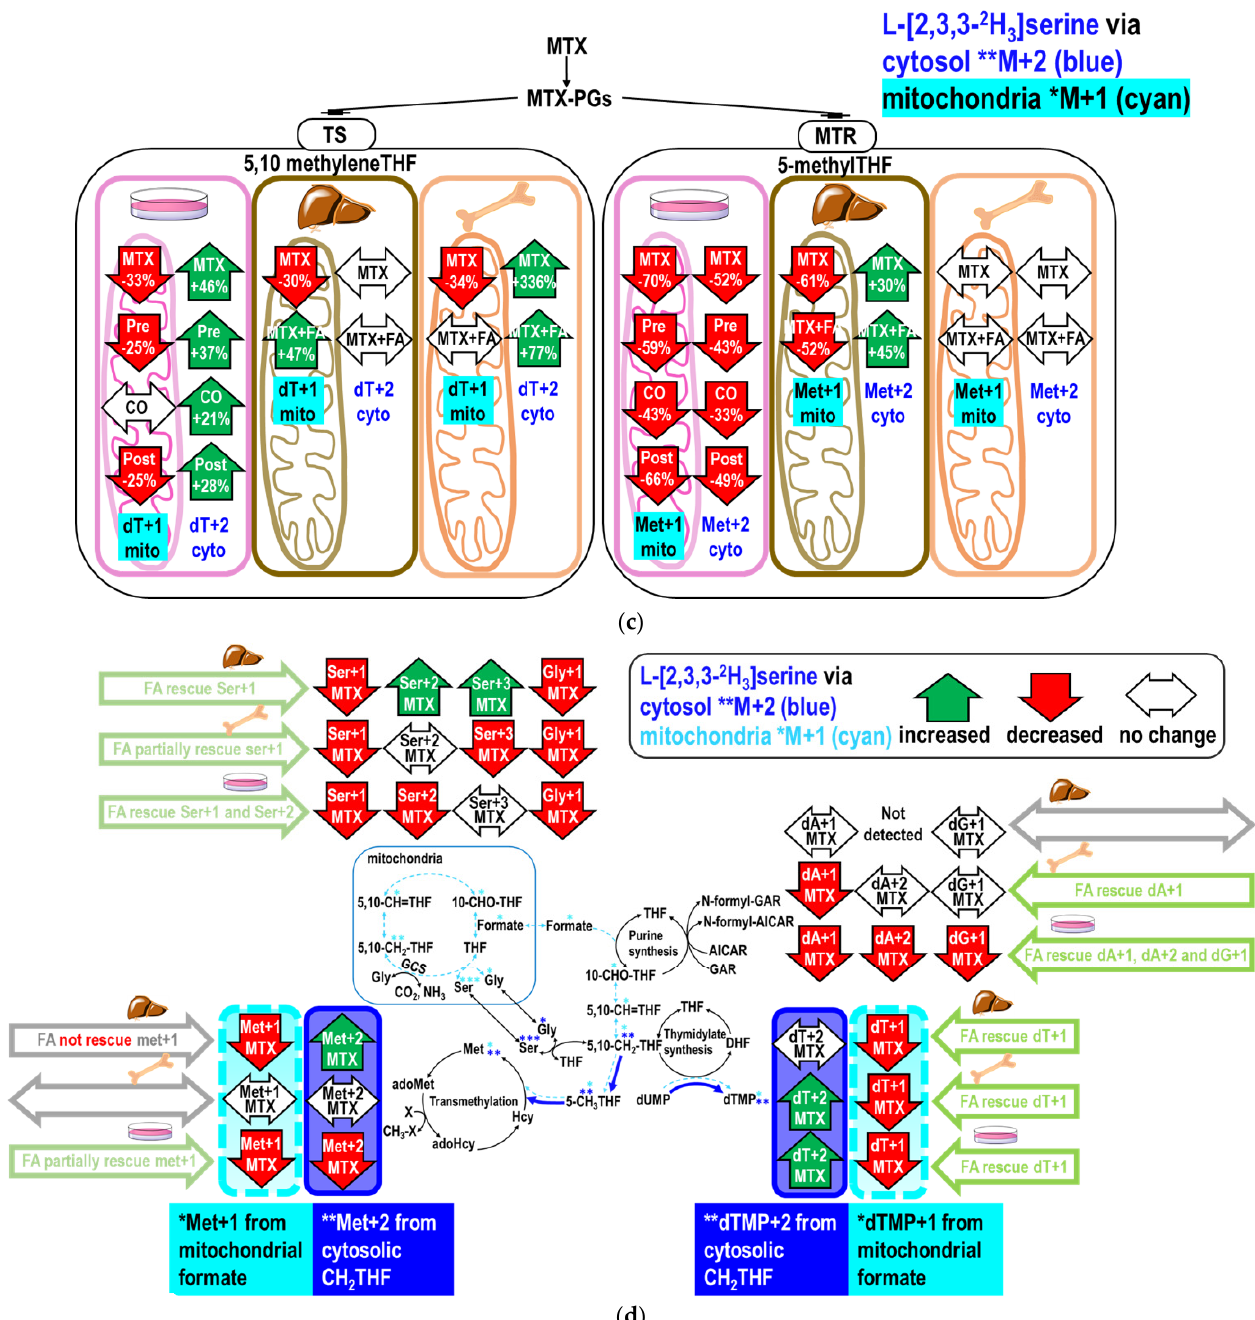
Figure 3. Effects of MTX on the partitioning between mitochondrial and cytosolic derived formate 1-carbon metabolic fluxes in vitro and in vivo. MTX and folinate alter the partitioning of 1C metabolic fluxes between mitochondrial (cyan M+1) and cytosolic (blue M+2) derived formate in dTMP and methionine synthesis in the ( a ) cell model and ( b ) mouse liver and bone marrow. Enrichment of dTMP (including dT+1 in cyan, dT+2 in blue) and methionine (including met+1 in cyan, met+2 in blue) were plotted as cumulative bar charts. Error bars represent the standard error of the mean. The proportional fluxes from mitochondria were calculated and shown in percentage (in cyan). The proportion of dTMP (dT+1) and methionine (Met+1) synthesized via mitochondrial 1C (cyan) and cytosolic 1C (blue) from L-[2,3,3- 2 H 3 ]serine were calculated and shown in the lower panel of the Figure 3a,b. Enrichments in dTMP (dT), methionine (Met), and deoxymethylcytosine (mC) derived from [2- 13 C]glycine, reflecting the utilization of GCS-derived formate, are shown in green. ( c ) The percent changes of the isotopic enrichments in each target compound compared to the control cells/animals re-